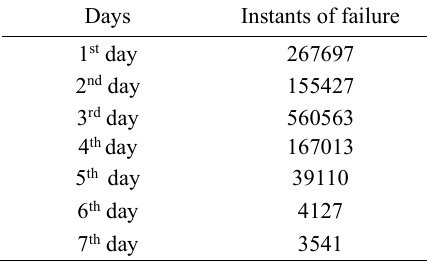
Table 4. Instants and types of